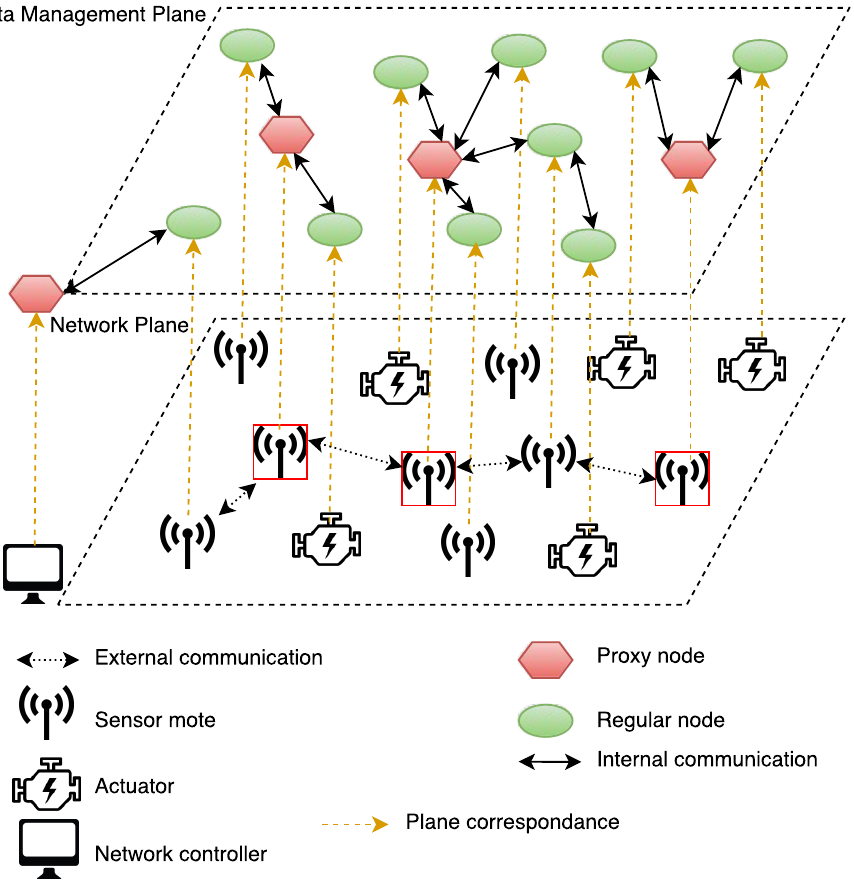
Figure 3. The Data Management Layer (DML): decoupling the data management plane from the network